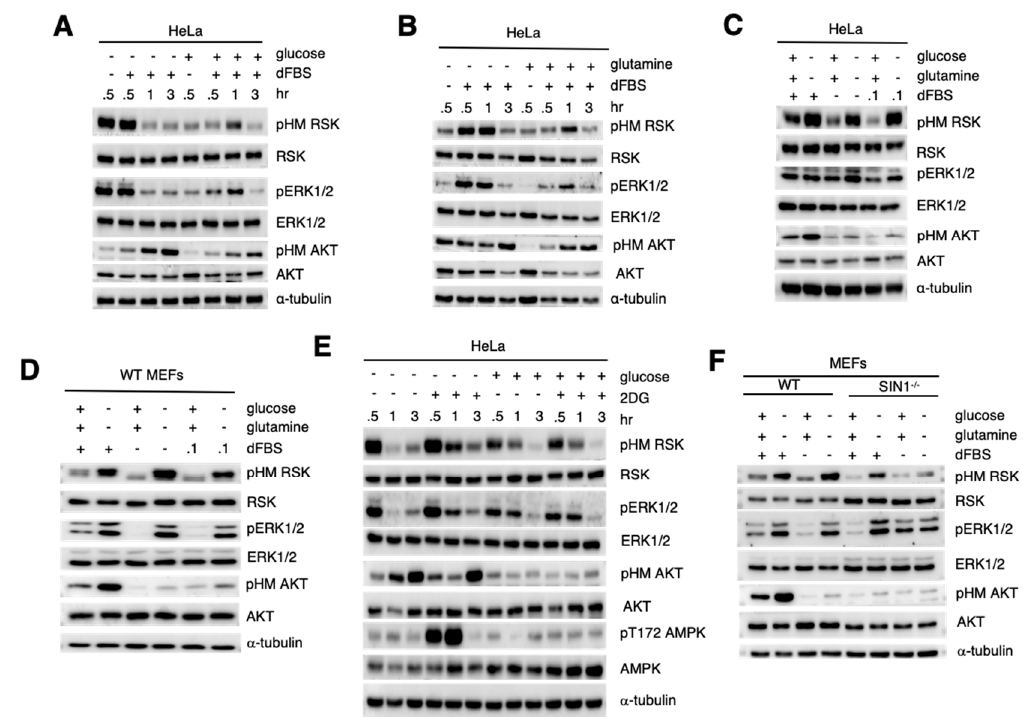
Figure 3. RSK HM site phosphorylation is increased during nutrient withdrawal. ( A – D ) . Growing HeLa ( A – C ) or WT MEFs ( D ) were resuspended in media with or without 1X dialyzed FBS (dFBS) (or 1× dFBS as indicated in ( C , D ) and lacking ( − ) or containing (+) either glucose ( A ), glutamine ( B ) or both glucose and glutamine ( C , D ) at the indicated times. In ( C , D ), cells were harvested after 1 h. Cells were lysed with RIPA buffer and processed for SDS-PAGE and immunoblotting. ( E ) Growing cells were resuspended in media with dFBS in the absence or presence of glucose and/or 500 μ M 2-Deoxyglucose (2DG) and incubated for the indicated times. ( F ) Growing WT or SIN1 − / − MEFs were resuspended in media lacking or containing glucose, glutamine and/or dFBS and incubated for 1 h before harvest. Cells were harvested and processed for SDS-PAGE and immunoblotting.